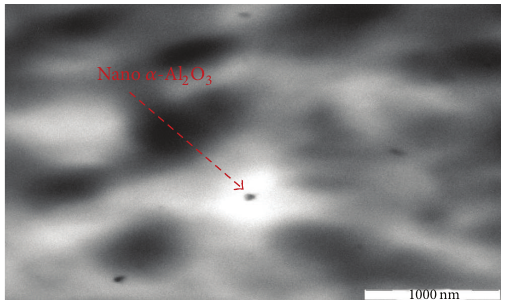
Figure 13: TEM observation of cryothin sectioning for PP/3% nano 𝛼 -Al 2 O 3 composites with dispersant.